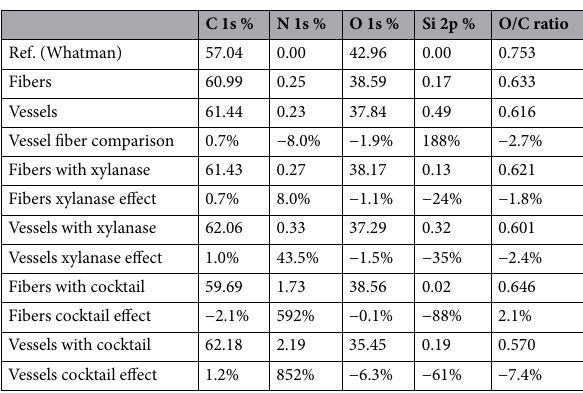
Table 5. Relative concentrations of elements in the samples surface